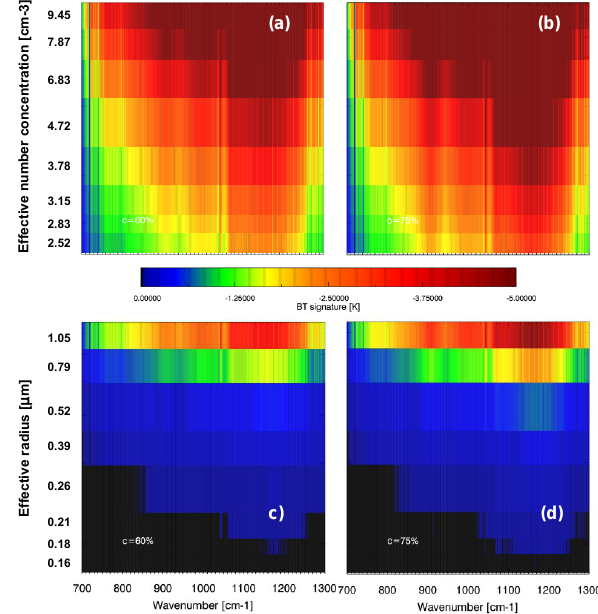
Figure 7. Spectral BT signatures for a sulfate aerosol layer at about 150hPa altitude, as a function of the effective number concentration N e for a fixed effective radius r e = 0 . 79µm (a, b) , and as a func- tion of the effective radius r e for a fixed effective number concen- tration N e = 7 . 87particlescm − 3 (c, d) . Sulfate aerosol layers are considered with 60% (a, c) and 75% (b, d) H 2 SO 4 mixing ratios at